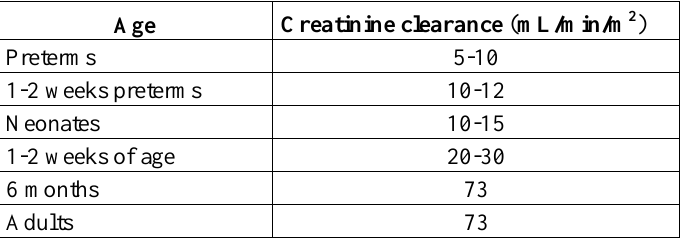
Table 4. Age-related creatinine